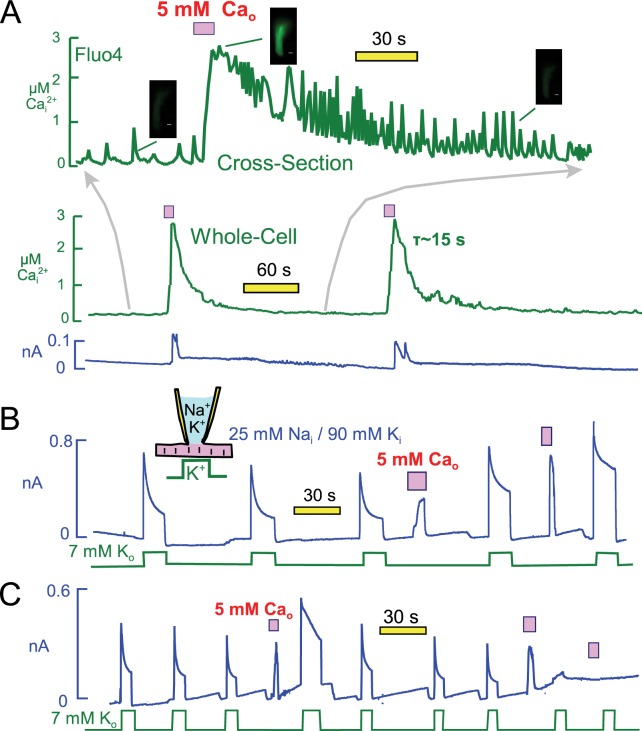
Free cytoplasmic Ca changes and their effects on Na transport currents during repeated Ca elevations.(A) Free Ca measurements with Fluo4. The center record presents the whole-cell free Ca signal measured with Fluo4. Fluorescence increased by 3.7 ± 0.4 fold (n = 7) during application of extracellular Ca and returned to baseline with a time constant of ~25 s. Correcting for dye nonlinearity, the fall of cytoplasmic Ca probably occurs with a time constant of ~15 s. The upper record shows in an expanded time scale fluorescence from a cross-sectional slice in the middle of themyocyte, revealing that extensive Ca waves are taking place in the myocytes. These waves become more rapid an large as free Ca declines, and finally they decline in both magnitude and frequency. (B) Representative for >400 observations, Na/Ca exchange current shows a time-dependent activation phase on first application of extracellular Ca. This secondary rise corresponds to the regulatory activation of exchangers that occurs as cytoplasmic Ca rises (Matsuoka et al., 1993). On second application of Ca, the exchange current activates immediately and to a higher magnitude than on initial Ca application. Thereafter, pump current is increased beyond its peak after the first Ca elevation. (C) After three or more Ca elevations, and infrequently after the second repetition, both Na/K pump and exchange currents decreased and often became negligible. The loss of transporter currents was often accompanied by declining membrane capacitance during Ca elevations, indicative of massive endocytosis (Lariccia et al., 2011).